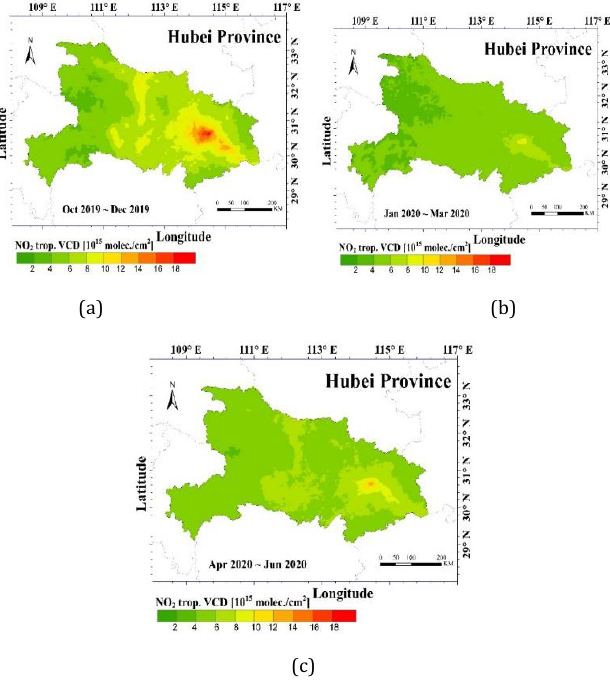
Figure 2: The spatial distribution of the TNO2_ave (a) three